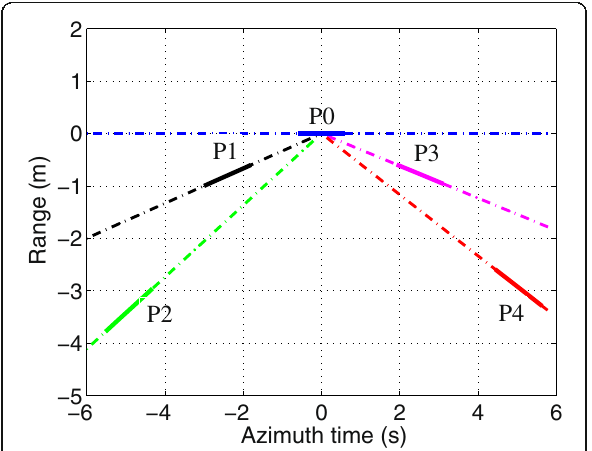
Fig. 6 Residual linear RCMs of the echoes after deramp